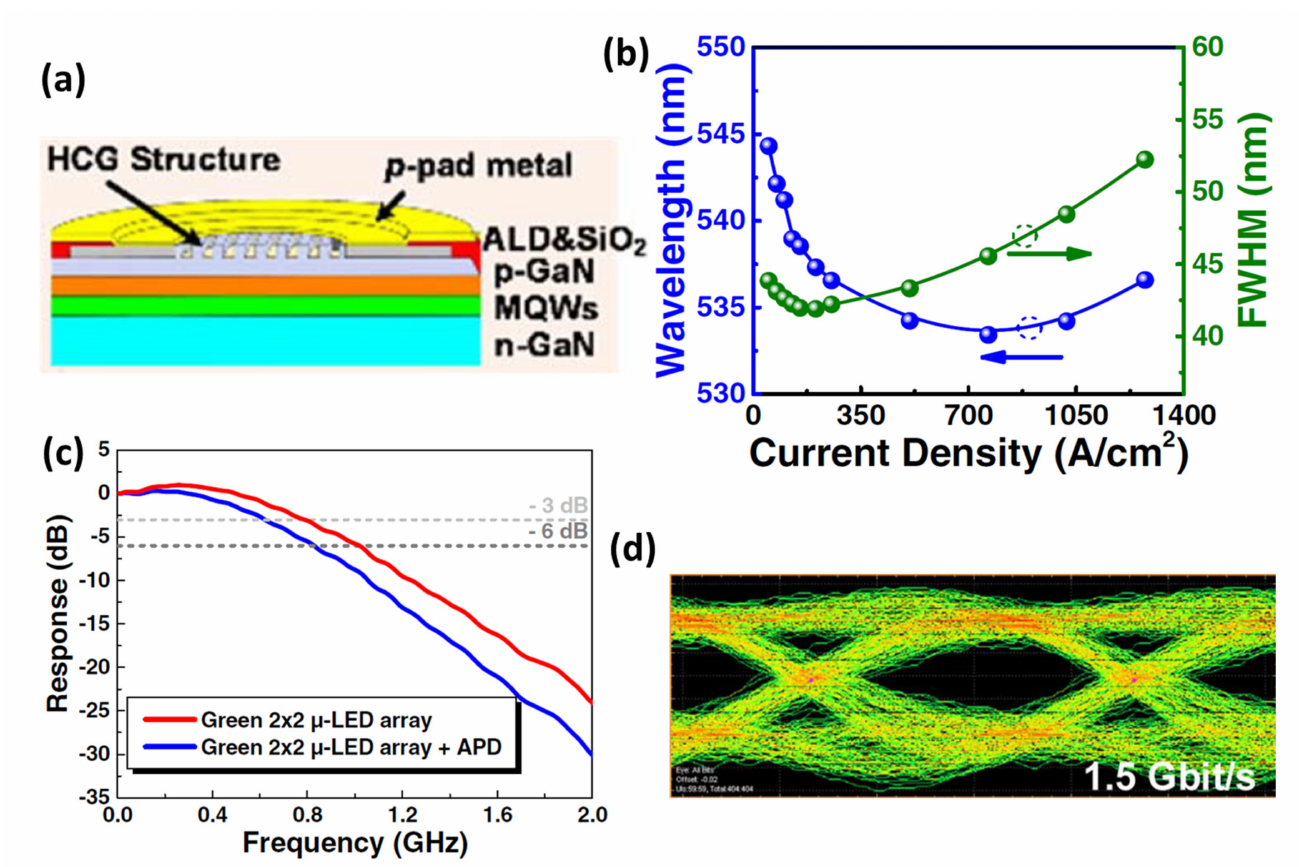
Figure 7. ( a ) Schematic diagram of micro-LED device structure within nanostructured grating patterns on top of the structure. ( b ) Peak wavelength and FWHM of the EL spectra. ( c ) Modulation bandwidth of the micro-LED array. ( d ) Eye diagram of the NRZ-OOK transmission at 1.5 Gbit/s. Ref. [63] Figures reproduced with permission from Optica Publishing